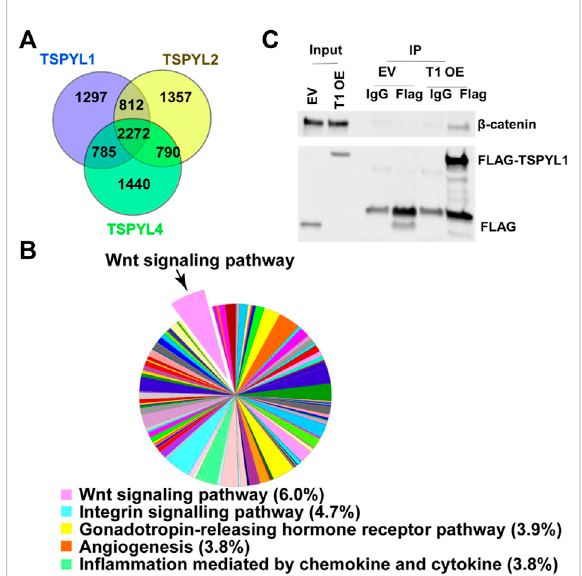
FIGURE 1 TSPYL1,2 and 4 interact with Wnt signaling pathway